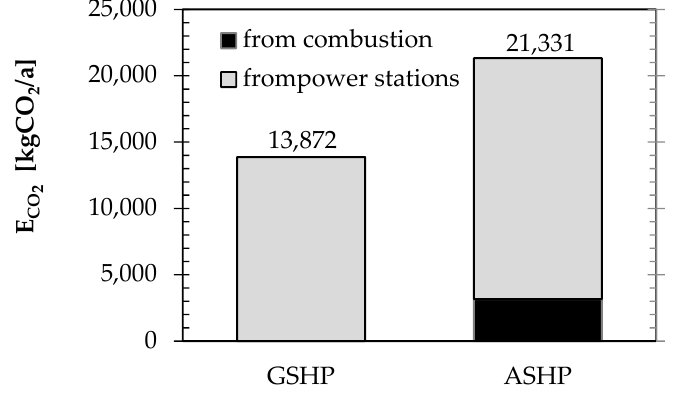
Figure 2. Carbon dioxide emissions form the two considered heat